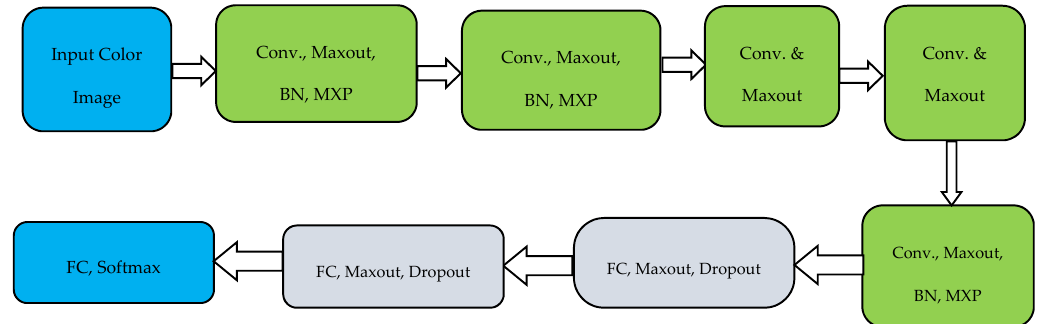
Figure 2. Overall architecture of the proposed AlexNet layers: convolution, max-pooling, max-out, BN and, FC.